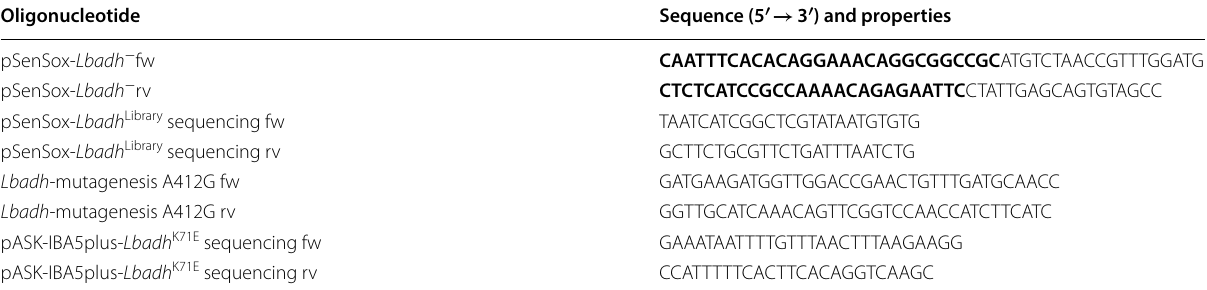
Overlapping regions required for Gibson assembly in oligonucleotides used for cloning of the Lbadh Library genes into pSenSox cut with EcoRI and HindIII are shown in bold